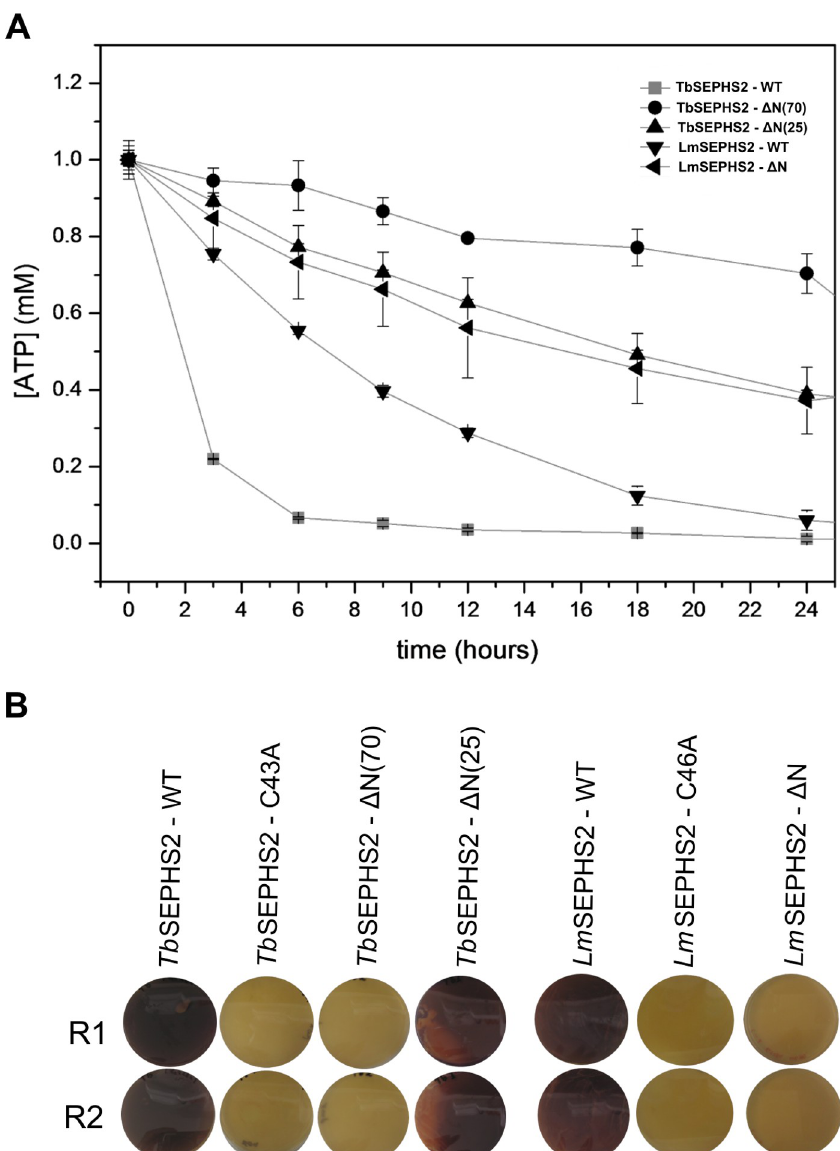
Fig 2. ATPase activity and functional complementation assays. A- ATP hydrolysis in vitro over time measured by HPLC for full length and N-terminally truncated constructs of T . brucei and L . major selenophosphate synthetases. B- Selenophosphate synthetase functional complementation assays in SEPHS deficient E . coli strain (WL400 (DE3)) transformed with different constructs. The purple color indicates a functional formate dehydrogenase H selenoprotein expression. R1 and R2 correspond to biological